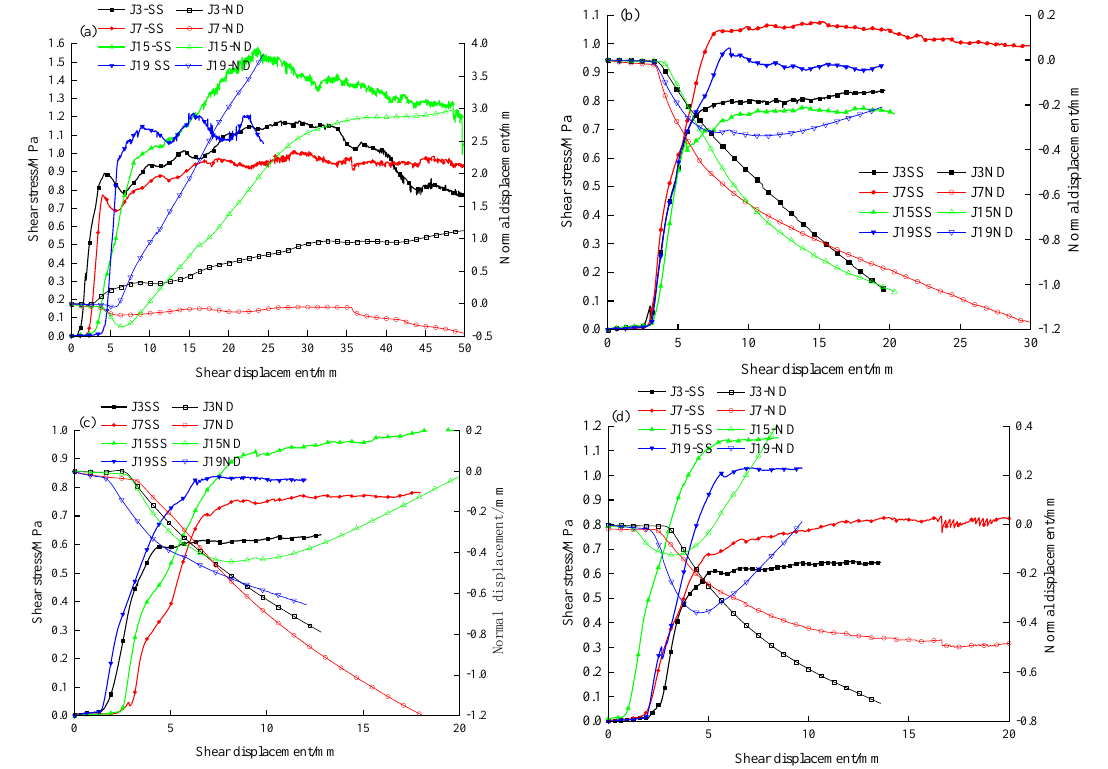
Fig.5. SS and ND versus SD curves under normal stress of 1.5 MPa: (a) without filling; (b) semi-solid soil; (c) plasticized soil; and (d) liquid soil. Table 1: Peak shear displacement and shear dilatation modes under different filling states. Without